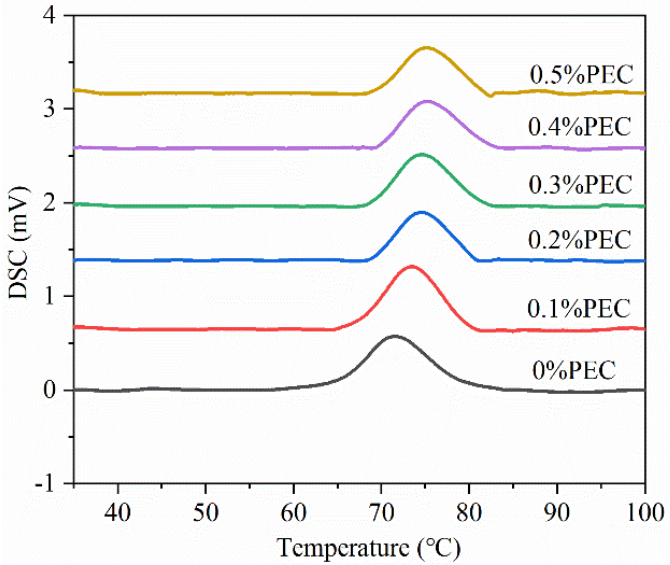
Figure 2. Thermograms of the WRS and the WRS–PEC mixtures. Table 2. Thermal parameters of the WRS and the WRS–PEC mixtures *.